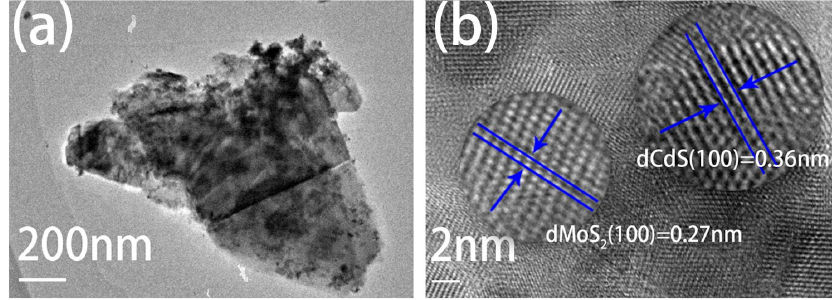
Figure 3. ( a ) Transmission electron microscopy (TEM) image of MC15; ( b ) high-resolution TEM (HRTEM) image of MC15.